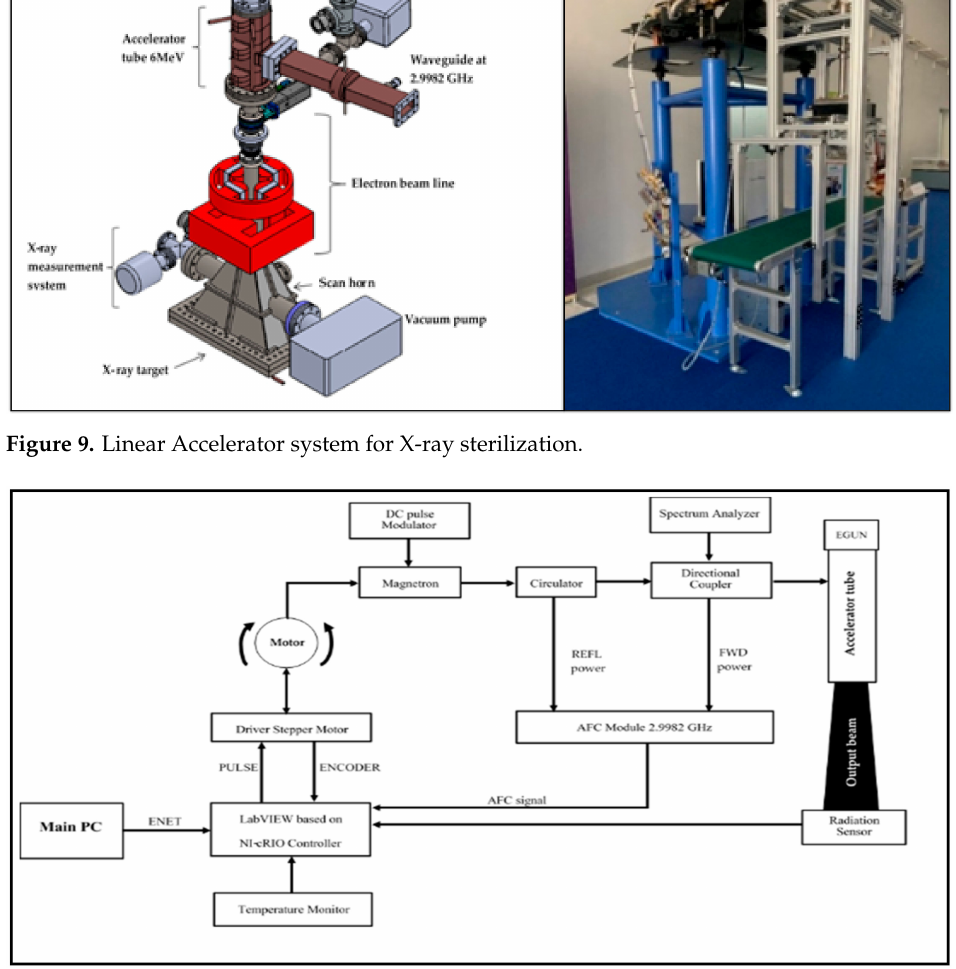
Figure 10. Block diagram of automatic frequency